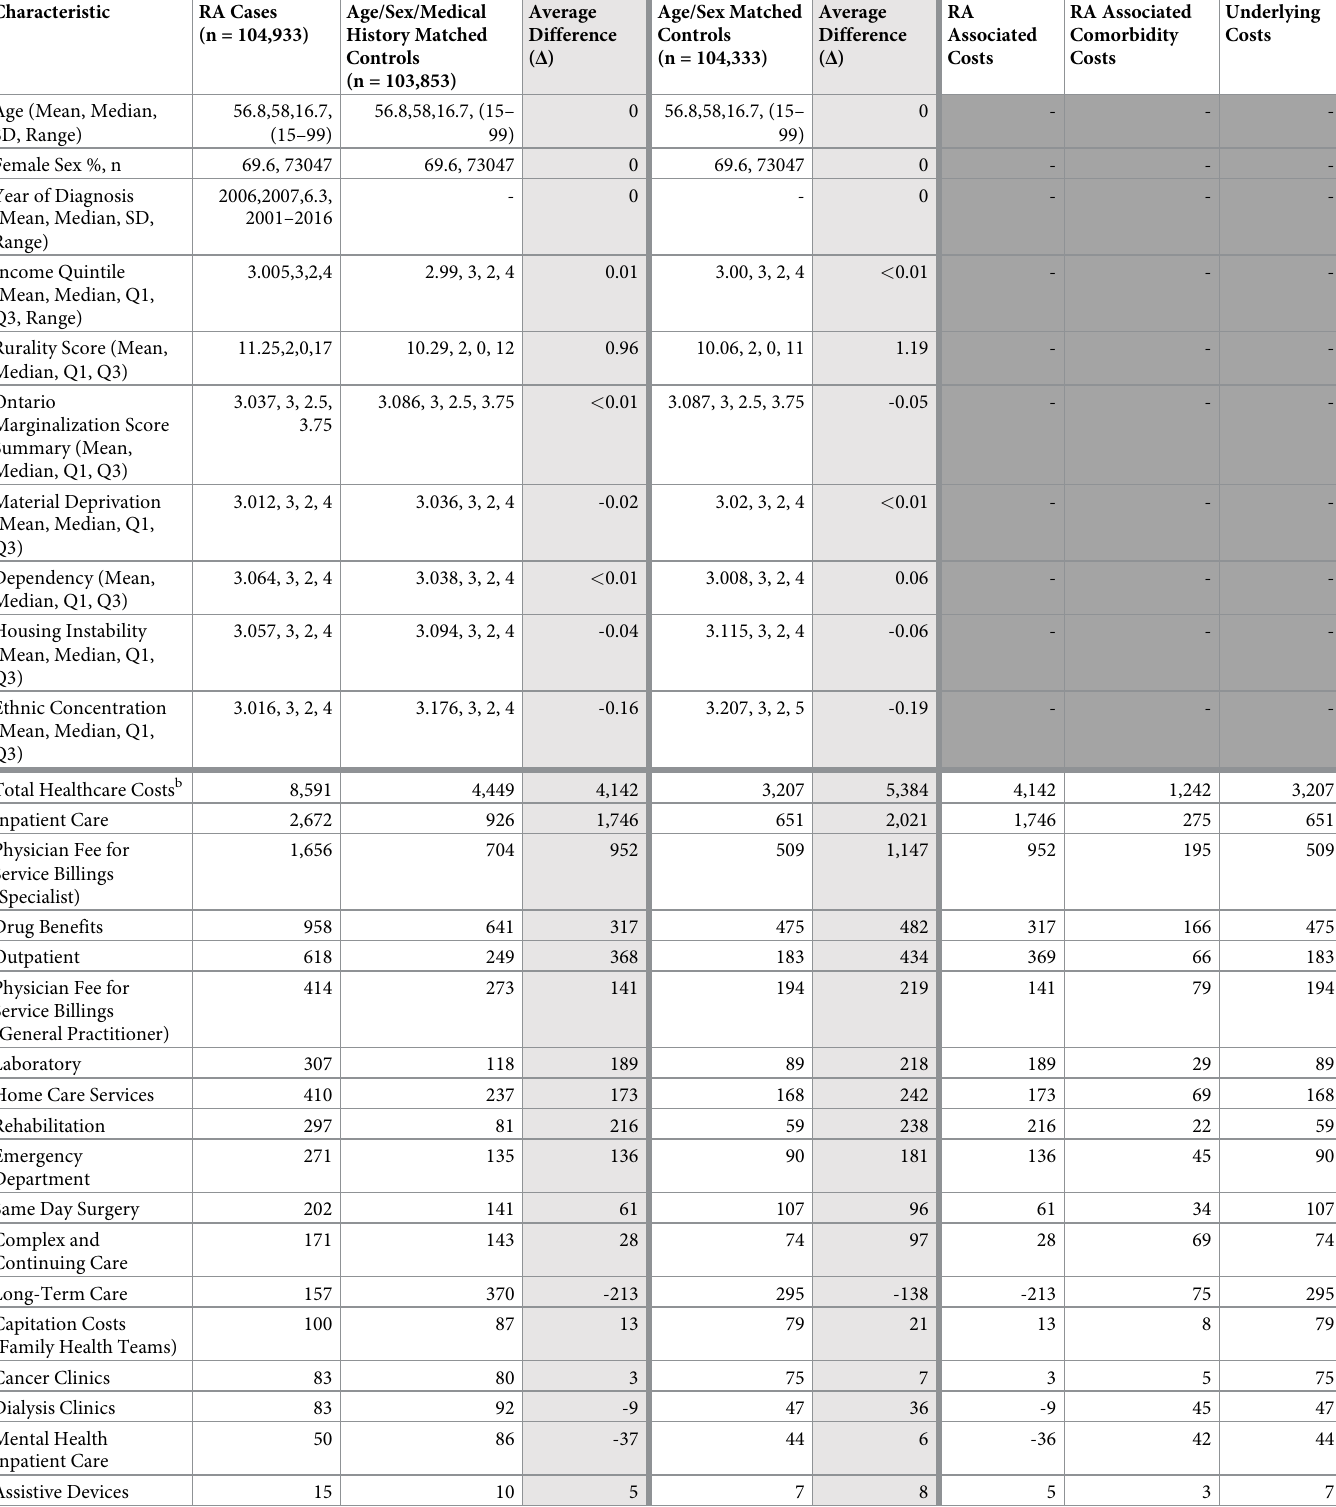
Table 1. Patient characteristics and costs at year of diagnosis for RA cases, index year for non-RA controls.